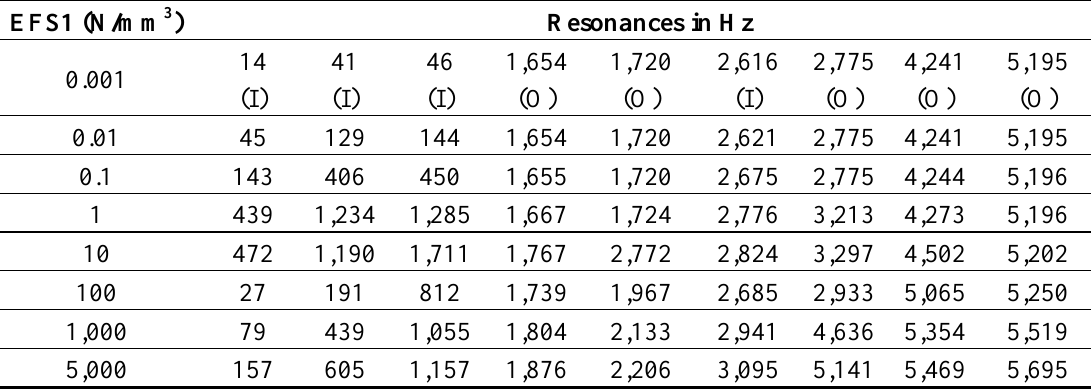
O: out-of-plane vibration mode; I: in-plane vibration mode. EFS1 (N/mm 3